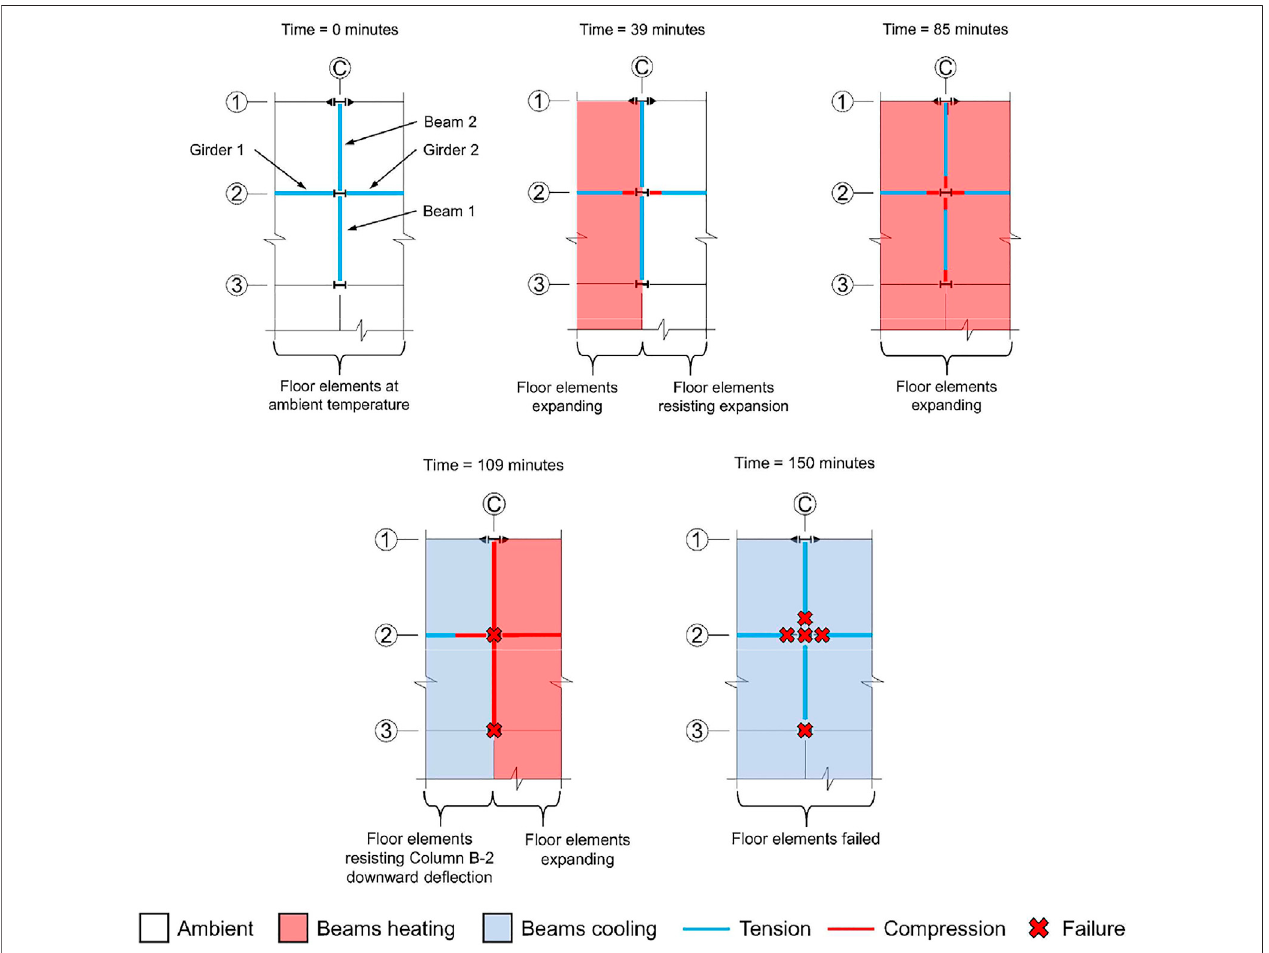
FIGURE 12 | Axial force behavior for fl oor framing elements around column C-2 in Fire Scenario #2.